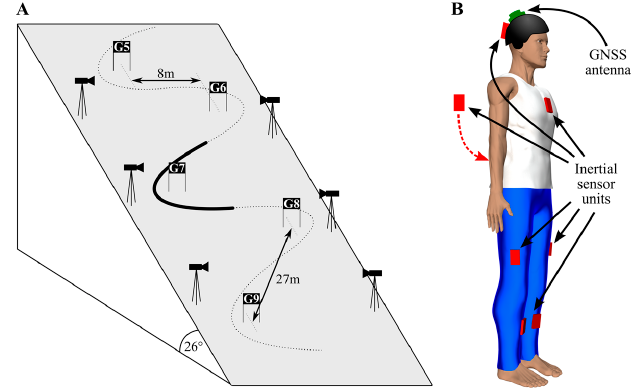
Figure 1. Materials and setup. ( A ) Illustration of the giant slalom slope. The left turn marked with the solid line was covered by the six cameras and analyzed in this study; ( B ) inertial sensors placed on both shanks and thighs, on the sacrum, sternum, and head. The global navigation satellite systems (GNSS) antenna was fixed to the athlete’s helmet.